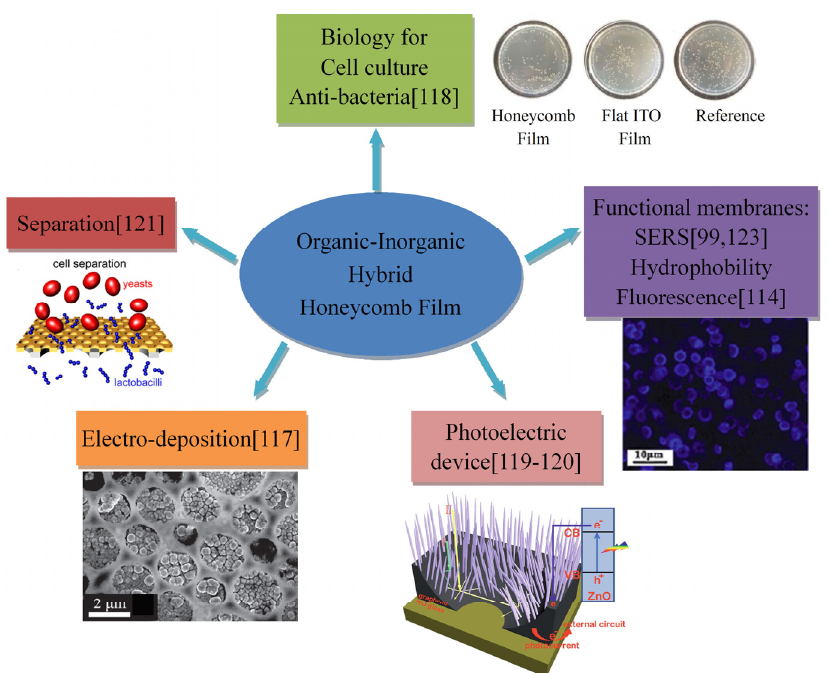
Figure 17. Summary of the applications of the organic-inorganic hybrid honeycomb